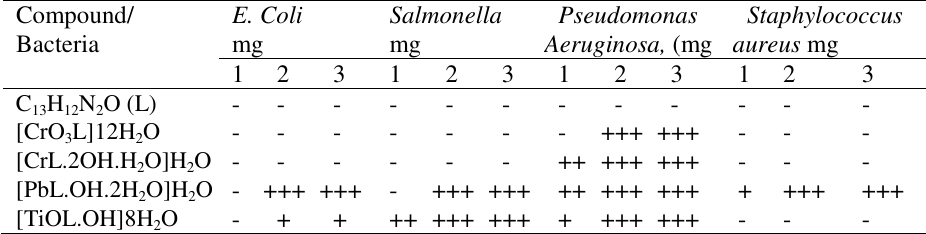
Table 4 . The effect of Schiff base and its complexes on the bacterial growth